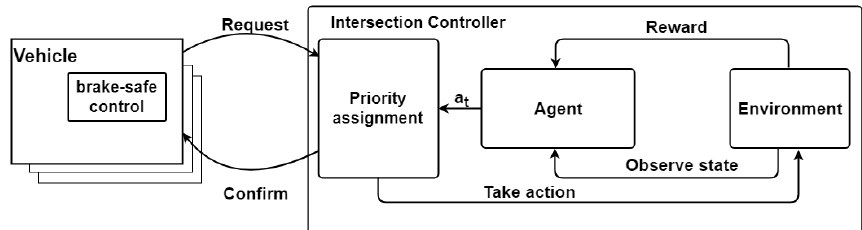
Figure 4. Deep Reinforcement Learning-based AIM